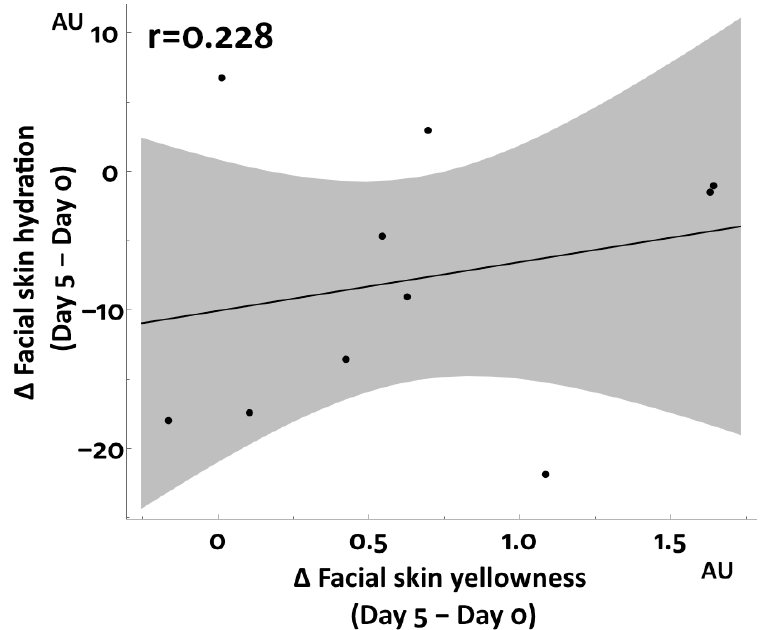
Figure 9. Association between facial skin yellowness and hydration in repeated partial sleep dep- rivation study.